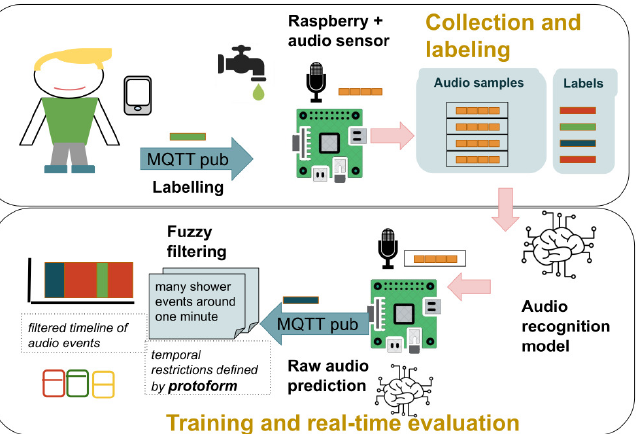
Figure 2. Architecture of components for ambient sound recognition of daily living events. The real-time prediction of sound events was carried out in smart boards under an edge–fog comput- ing